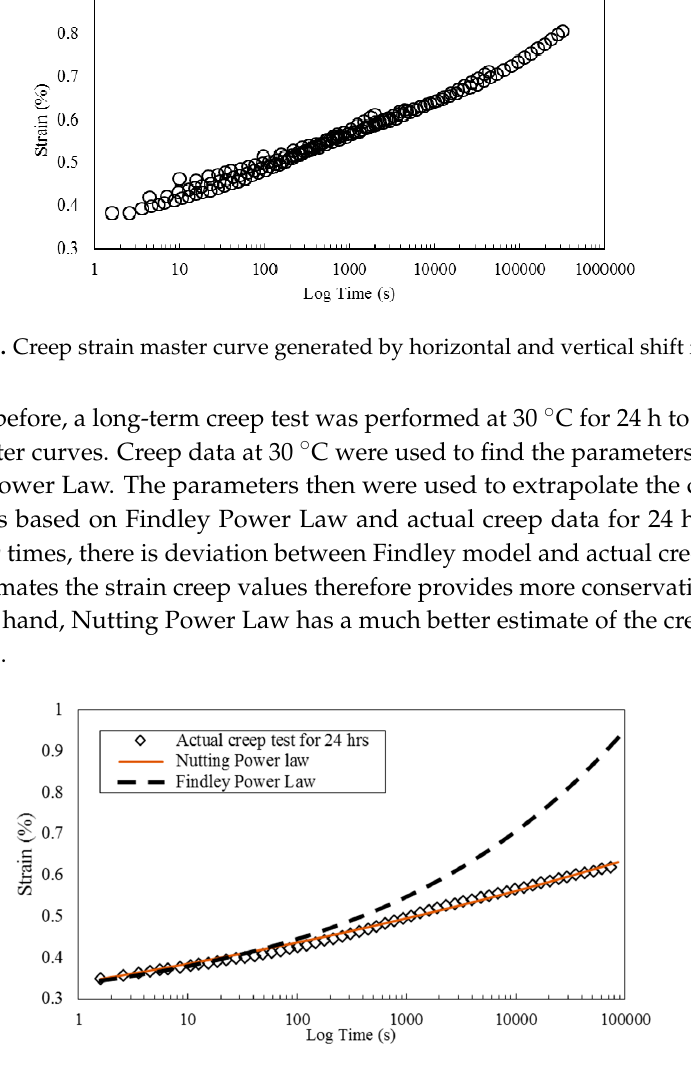
Figure 12. Creep strain curves at different temperatures shifted by the horizontal shift factors obtained from storage modulus master curve.